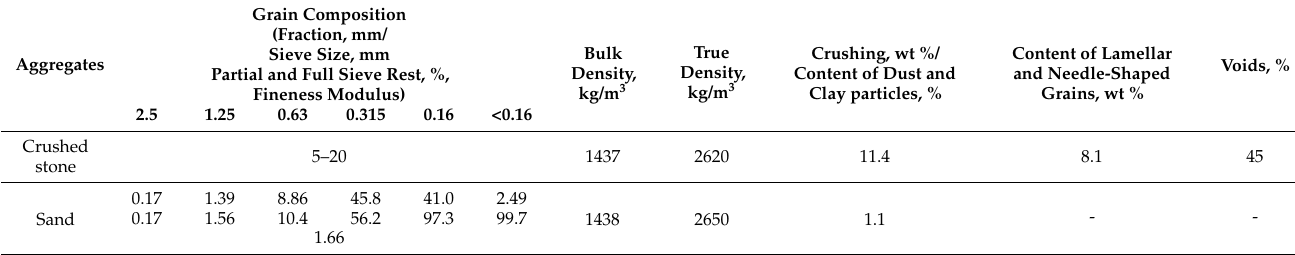
Table 2. Physical and mechanical characteristics of aggregates.